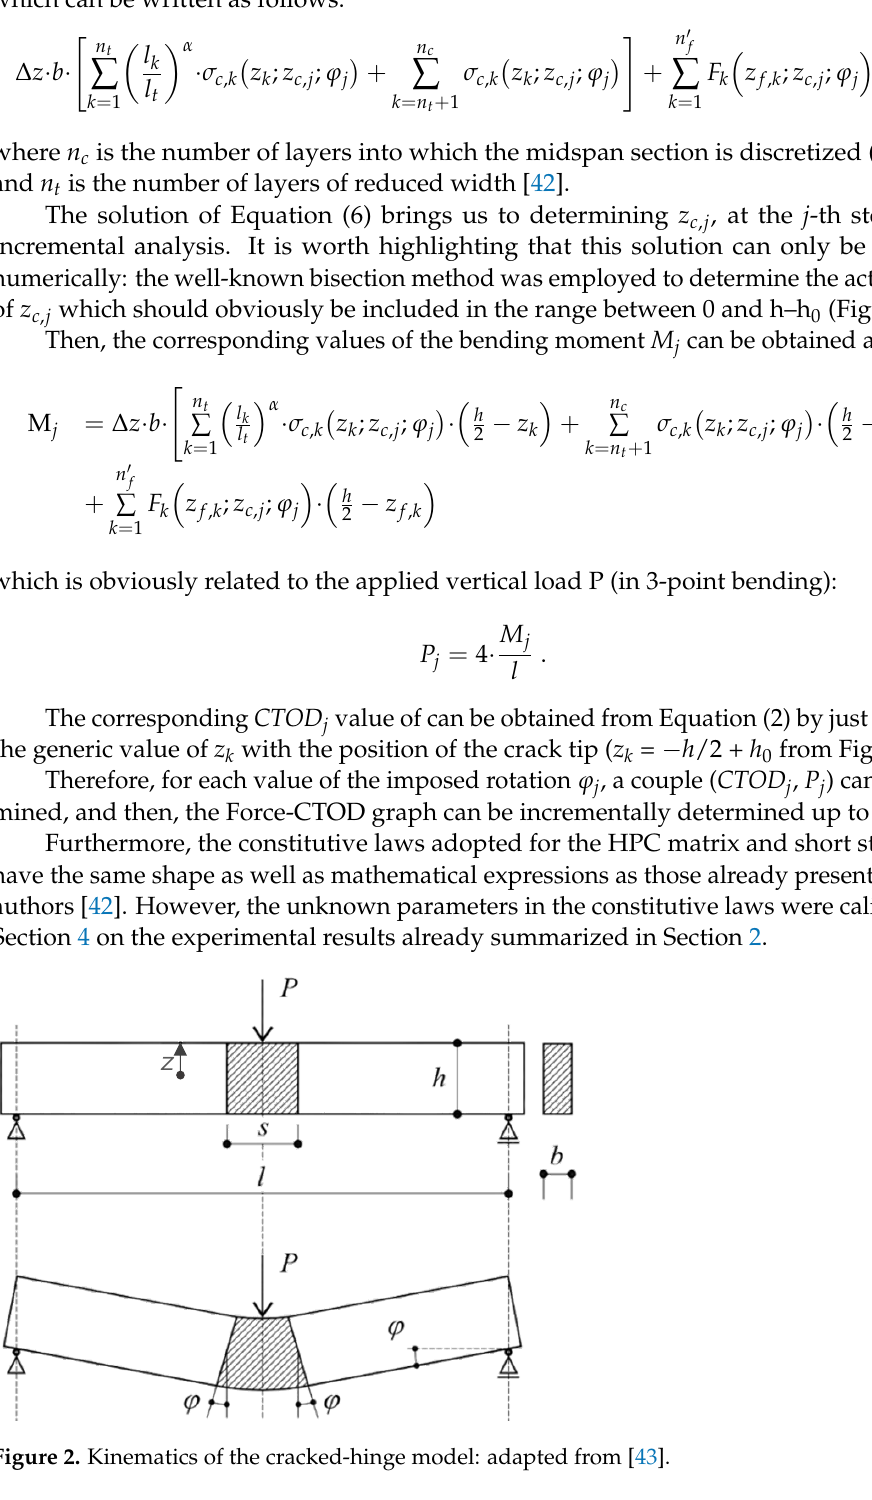
Figure 3. Notched cross-section ( a ) and diagram of normal strain ( b ). Figure 4. Notched cross-section with exponential law of the reduced width, 𝑏 𝑘 , in the transition zone, 𝑙 𝑡 : ( a ) linear expression ( 𝛼 = 1) of 𝑏 𝑘 , ( b ) exponential expression with 𝛼 > 1 , ( c ) exponential expression with 𝛼 < 1 . 3.2. Constitutive Laws Assumed in the Present Study 3.2.1. Stress – Strain Relationships for Concrete in Compression and in Tension The stress – strain relationship when the concrete is in compression was described by Equation (7), according to 54, in which 𝜂 can be calculated as the ratio between the strain, 𝜀 𝑐 , and the strain at maximum compressive stress, 𝜀 𝑐1 , can be evaluated as in Equation (8); whereas 𝑘 is the plasticity number which depends on the elastic modulus in